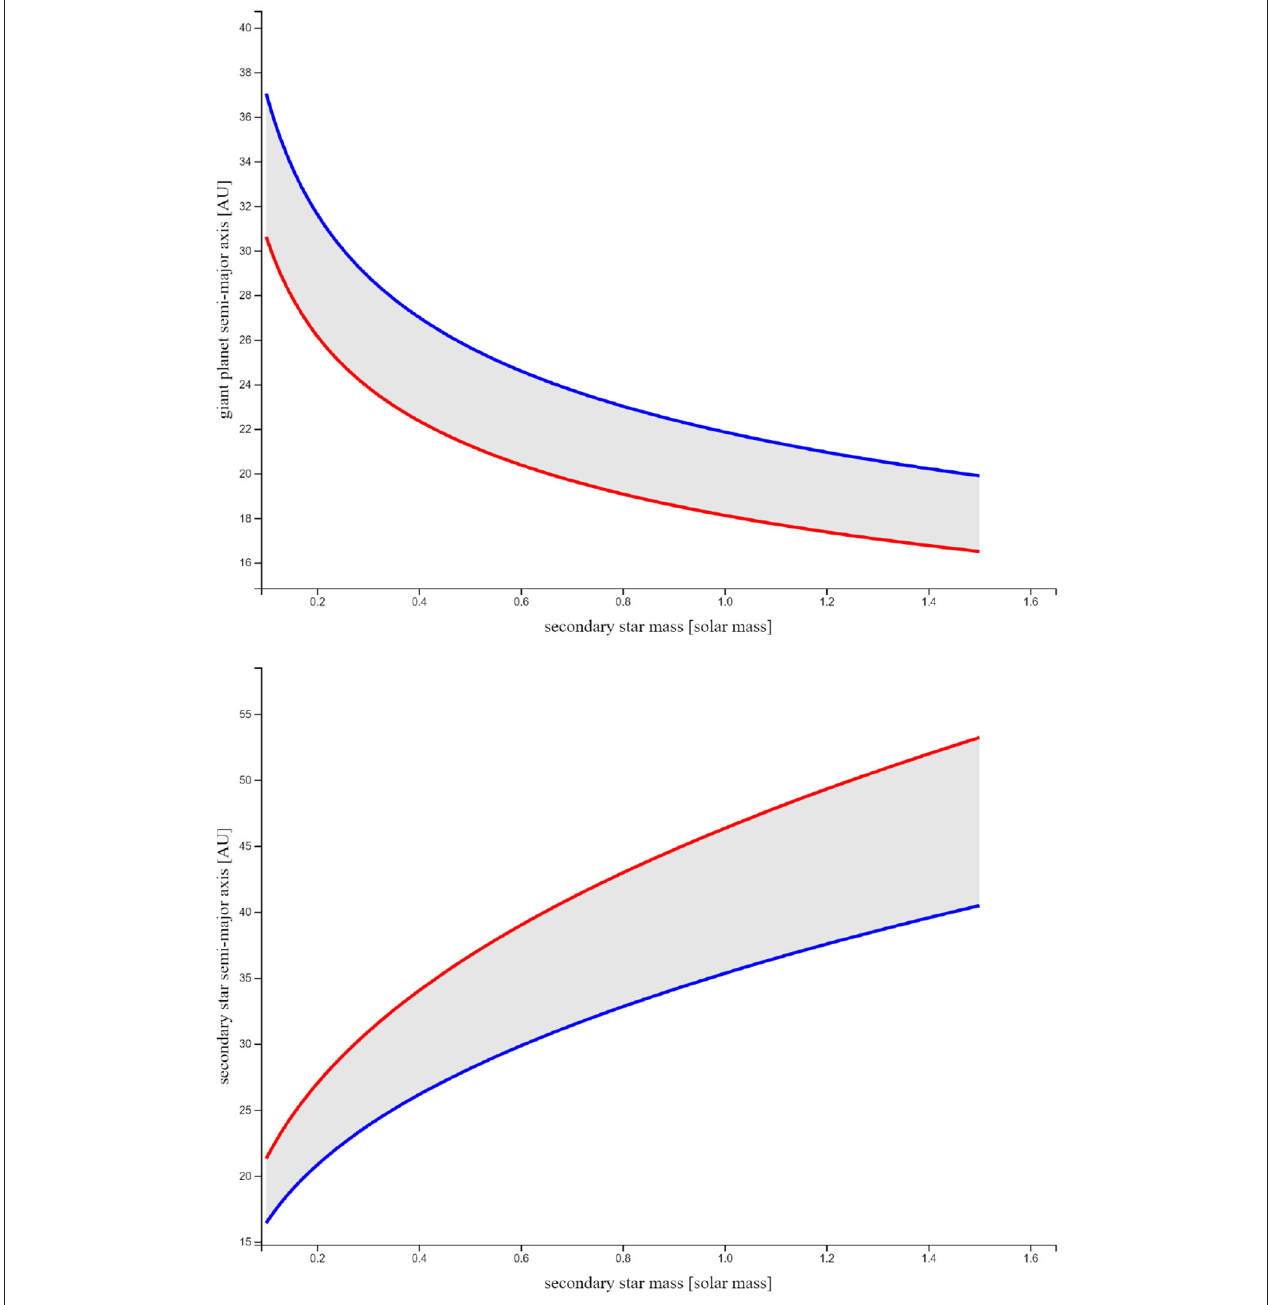
FIGURE 4 | Same as Figure 3 but for the variation of the stellar mass (x-axis) vs. the variation of the semi-major axis either of the giant planet (Upper) or of the secondary star (Lower) in the y-axes.